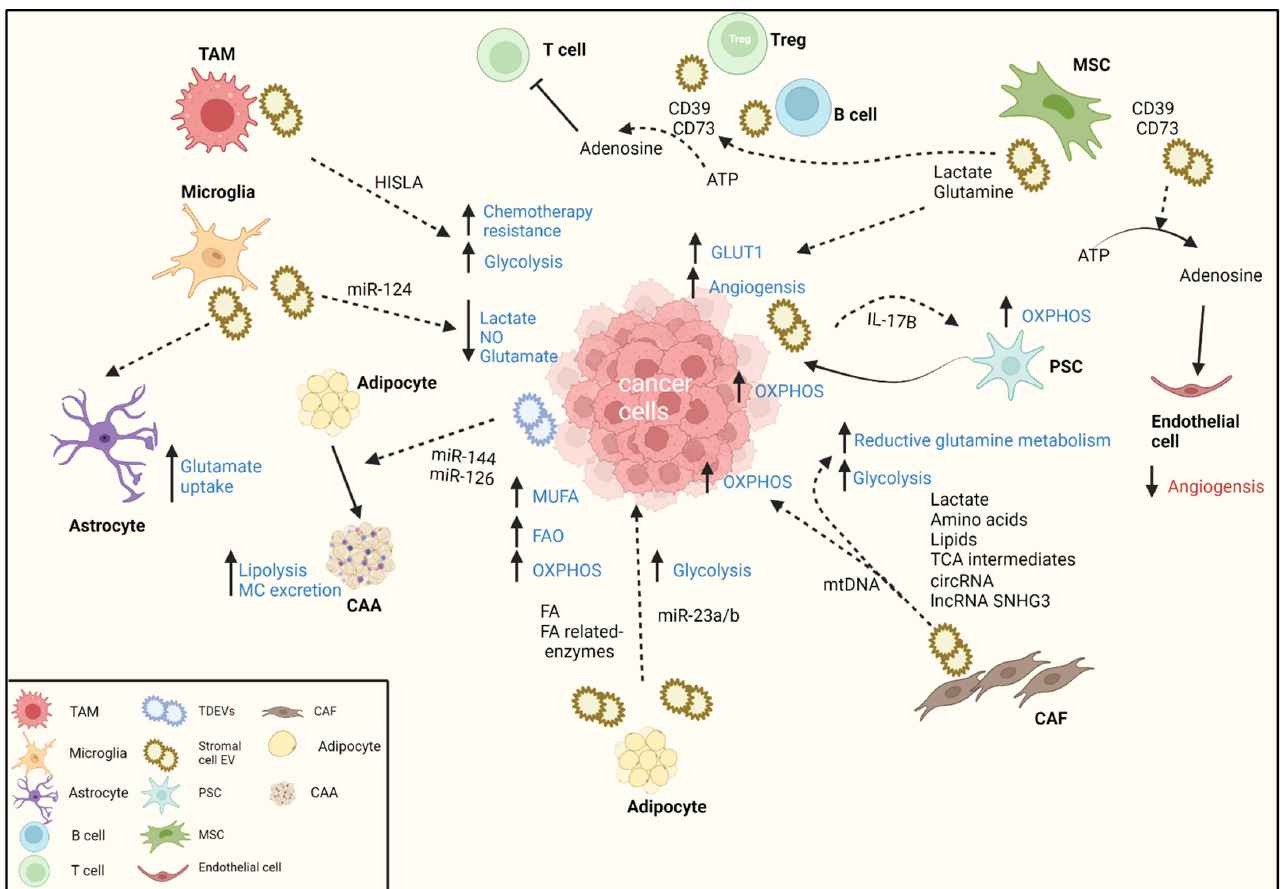
Figure 2. Tumor microenvironment metabolic reprogramming by stromal-derived extracellular vesicles. There is crosstalk between stromal cells and cancer cells. The metabolic landscape is dynamic and depends upon the availability of nutrients and complex TME communication. This can result in opposing effects for EVs. Stromal EVs transfer different metabolites to support cancer cells. CAFs transfer amino acids and TCA cycle intermediates to cancer cells to induce